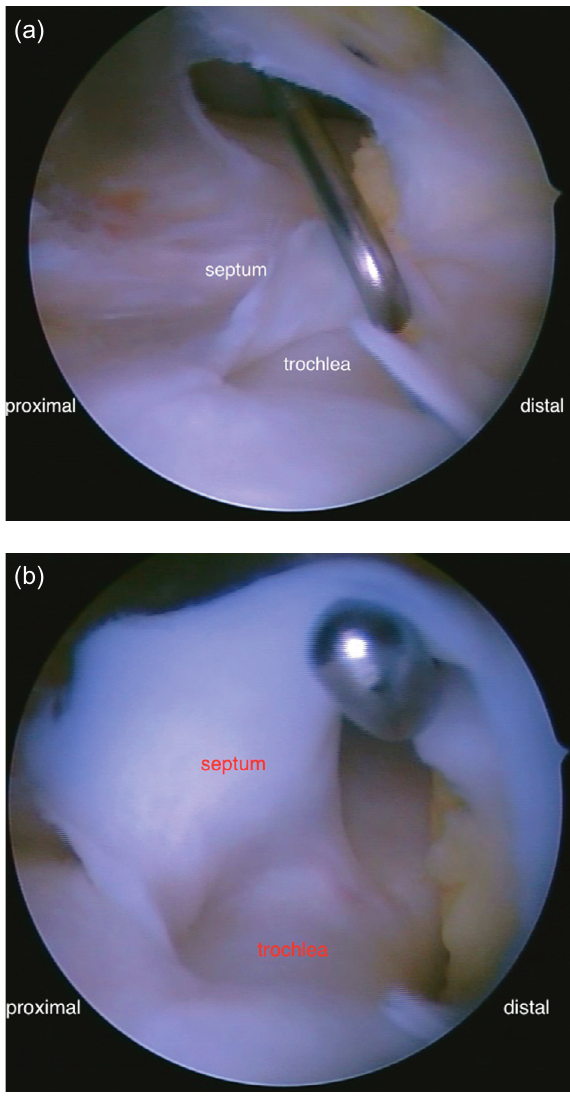
Figure 3. (a) Arthroscopy of the right knee from the anterolateral portal showed a strong sagittal septum in the femoral trochlea dividing the knee joint in a lateral and medial compartment. We perforated the septum with a hook via a high anteromedial portal and resected the septum. (b) The septum was adherent to the trochlear groove.